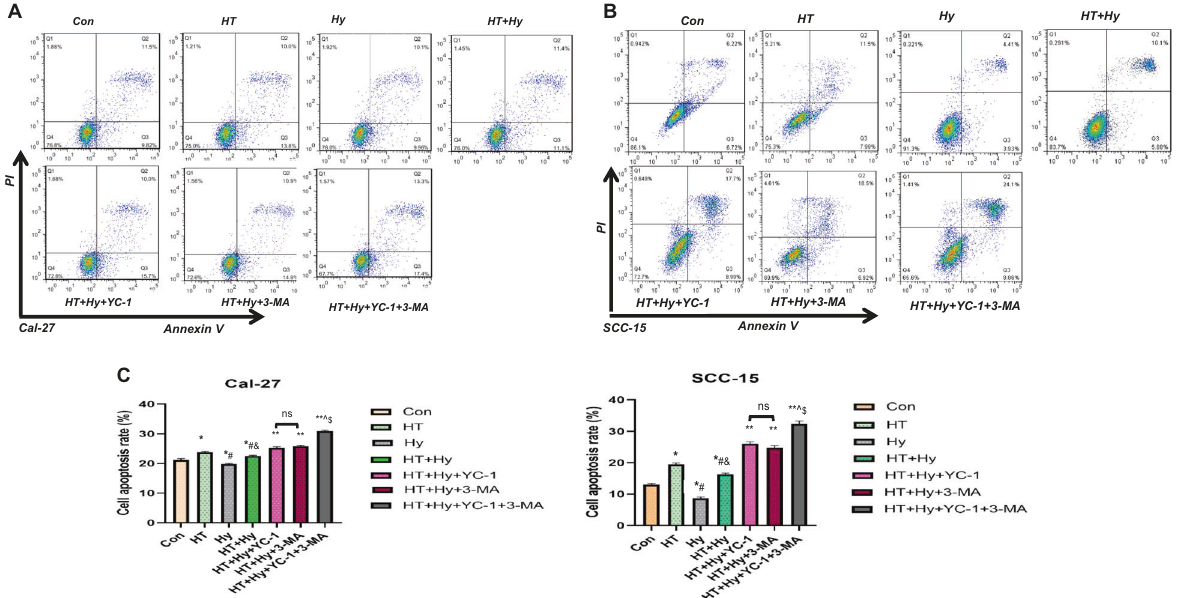
Fig. 7 HT combined YC-1, 3-MA alone or both facilitated the apoptosis of Cal-27 and SCC-15 cells in hypoxia and starvation microenvironment, as measured by fl ow cytometry. Data were presented as the mean ± SEM from three independent experiments. Con control, HT hyperthermia, Hy hypoxia, YC-1: 3-(5 ′ -hydroxymethyl-2 ′ -furyl) − 1-benzylindazole; 3-MA: 3-Methyladenine. The histogram of cell apoptosis rate after treatments were analyzed. * p < 0.05 vs. Con group; # p < 0.05 vs. HT group; & p < 0.05 vs. Hy group; ** p < 0.05 vs. HT + Hy group; ^ p < 0.05 vs. HT + Hy + 3-MA group; $ p < 0.05 vs. HT + Hy + YC-1 group; ns no signi fi cant difference ( p >